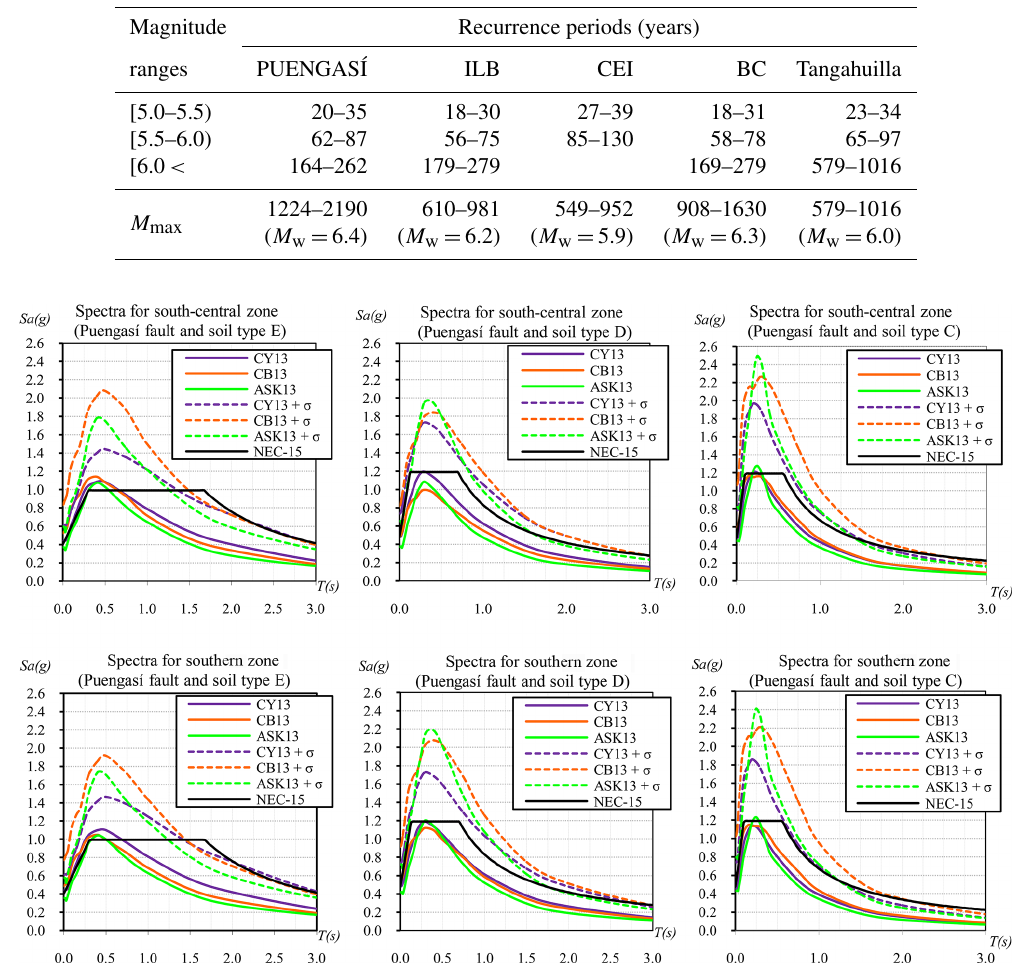
Figure 8. Spectra for south-central and south zones of